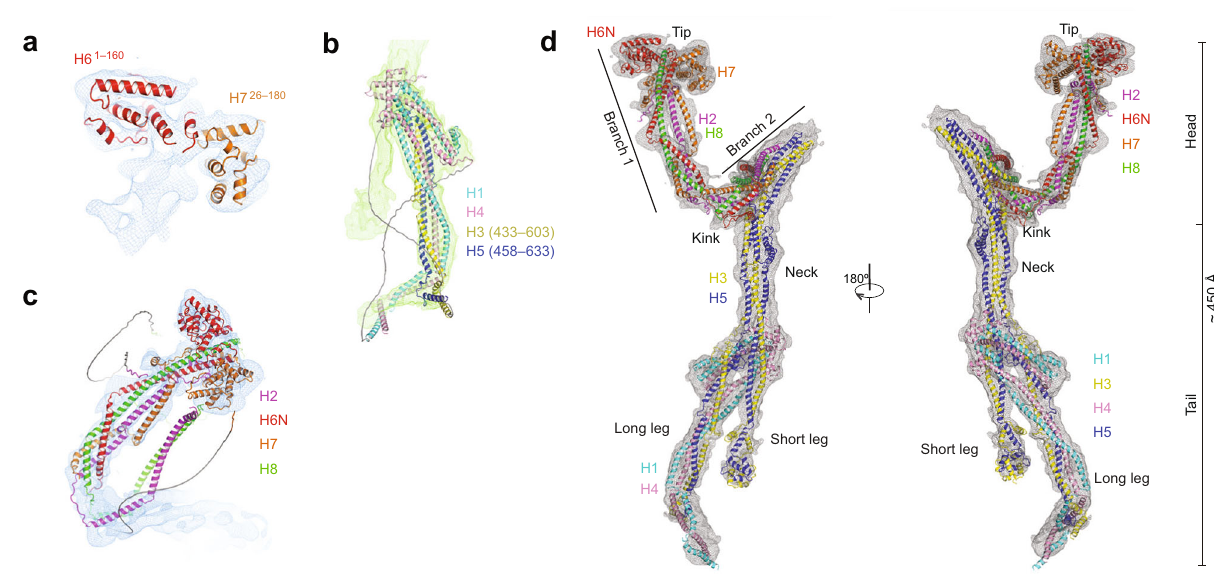
Fig. 2 | Fitting ofHAUS subunitsand fullatomicmodelofaugmin. a Rigid-body fi tting of the individual AlphaFold2 predictions of H6 (a.a. 1 – 160) and H7 (a.a. 26 – 160) within the cryo-EM map of the tip of branch 1. b Rigid-body fi tting of the